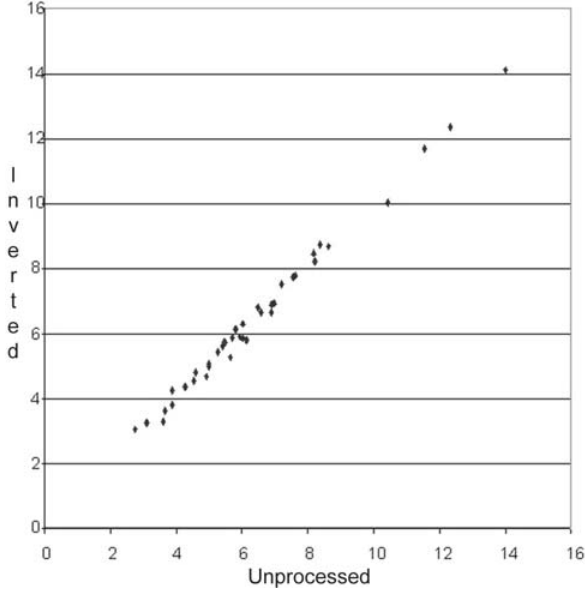
FIGURE 2- Linear measurements according to the type of radiograph (I= inverted and TABLE 1- Means, standard deviations (SD), coefficients of variation of bone loss measurements (mm) in inverted and unprocessed digitized radiographic imaging